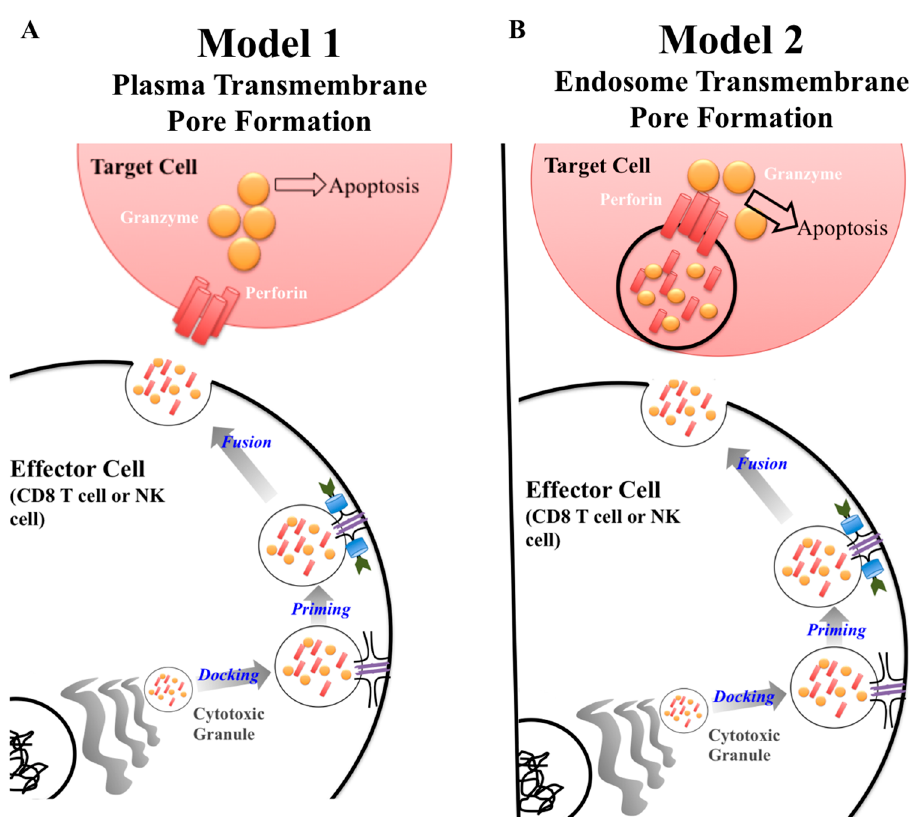
Figure 1. Current models of perforin granzyme synergy to induce apoptosis. There are two models to explain the synergistic effect between granzymes and perforin to induce apoptosis in a target cell. Both models are similar in regards to the process by which cytotoxic granules are produced by the effector cell. The difference lies at the target cell membrane surface. In Model 1, perforin forms a pore on the plasma membrane of the target cell allowing granzyme to be delivered to induce apoptosis ( A ). In model 2, granzyme and perforin are released from the cytotoxic granule, enter the target cell, and are then repackaged within the endosome. Perforin then forms a pore within the endosome, disrupting the membrane integrity, allowing granzyme to escape and induce apoptosis ( B ).